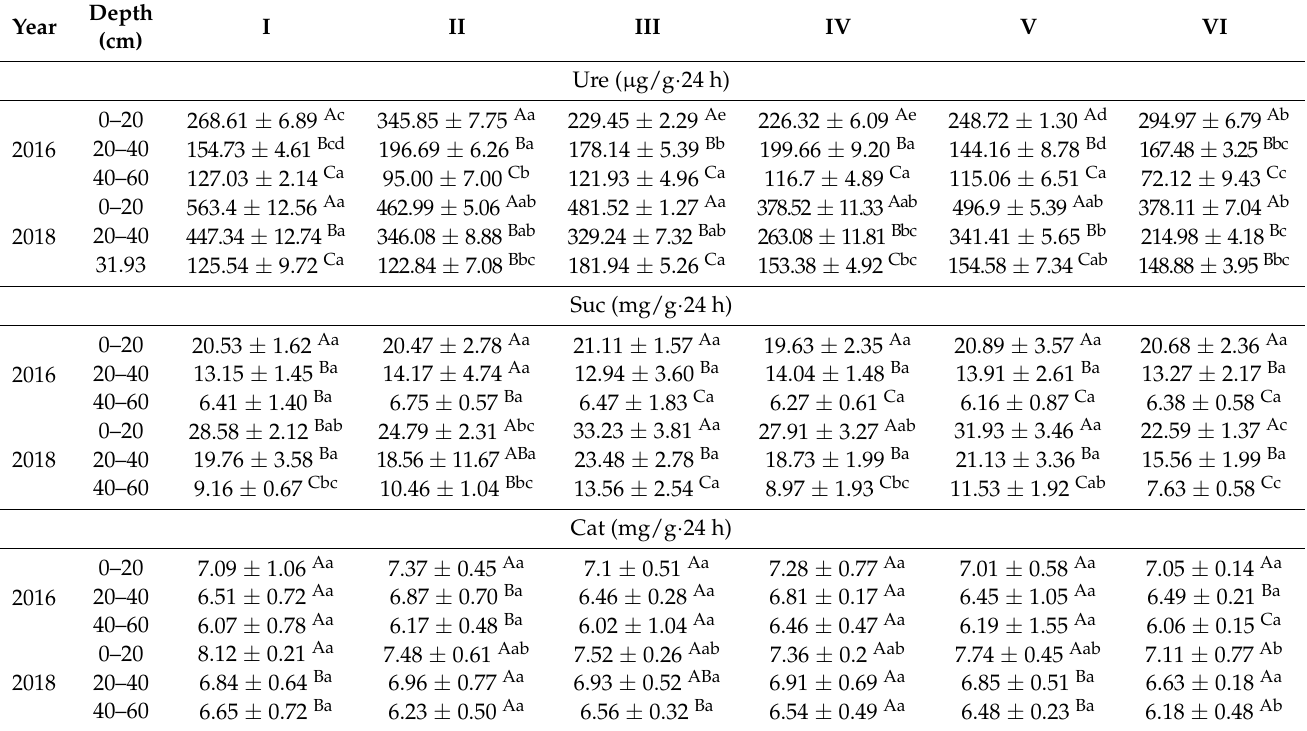
Table 4. Description of soil enzyme activities under six forest stands at 0–20, 20–40, and 40–60 cm (mean ± stand error, n =